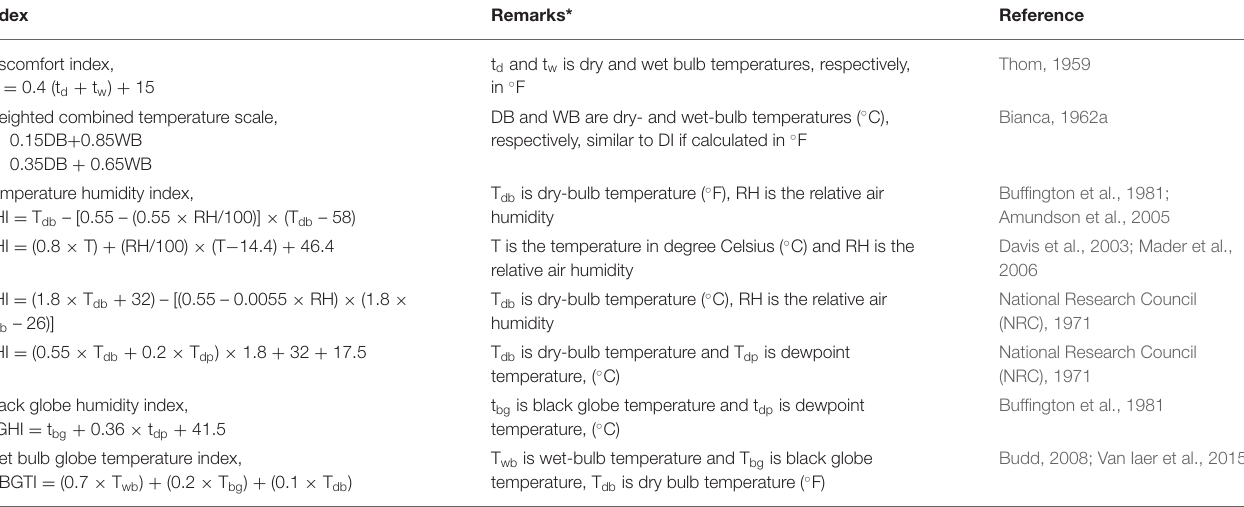
TABLE 2 | Thermal indices based on temperature and